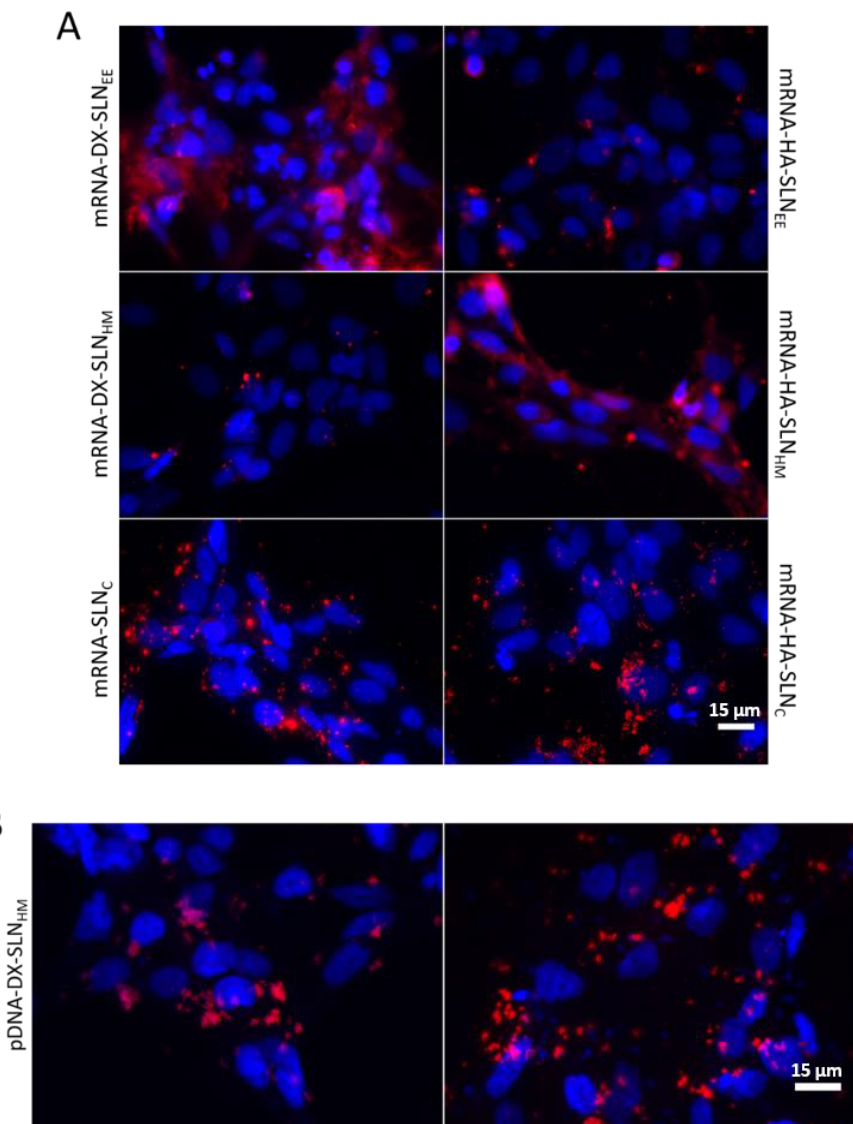
Figure 4. Confocal microscopy analysis of intracellular disposition of mRNA- and pDNA-based vectors 4 h after their addition in HCE-2 cells. ( A ) CleanCap™ Cyanine 5 EGFP mRNA (5moU) vectors formulated with P, DX and HA. ( B ) pcDNA3-EGFP plasmid labeled with Label IT ® Cy ® 5 vectors. Blue: nuclei labeled with DAPI. Red: fluorescence signal of nucleic acid labeled with Cy ® 5. Magnification 60×. Scale bar: 15 µm. DX: dextran; HA: hyaluronic acid; SLN EE : solid lipid nanopar- ticle prepared by emulsification-evaporation method. SLN HM : solid lipid nanoparticle prepared by